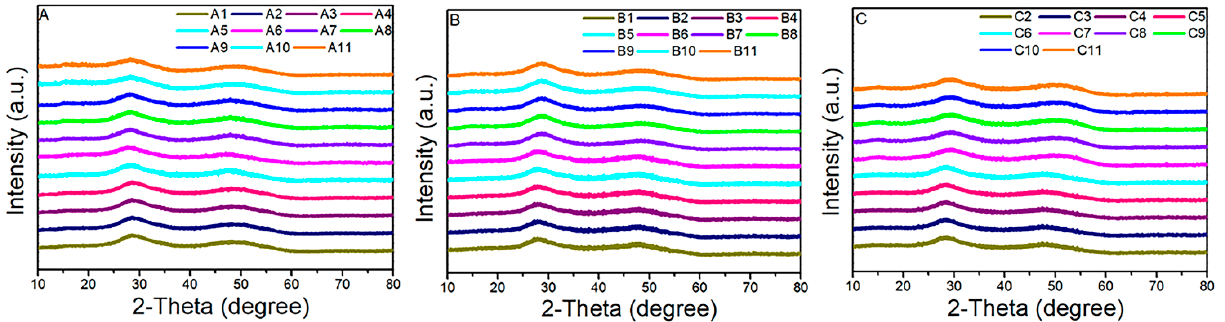
Figure 2. XRD diffraction patterns of GAST